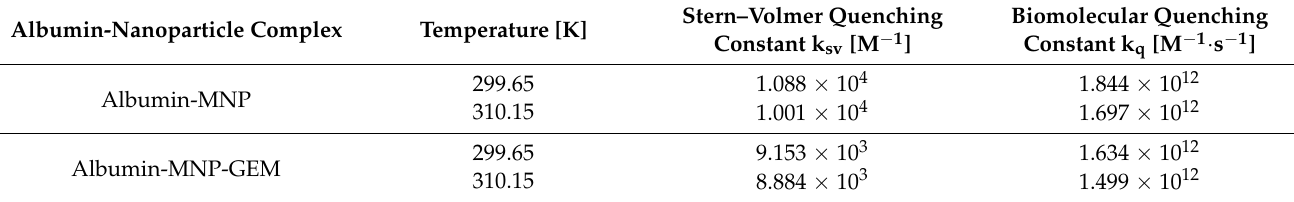
Table 1. The quenching constants of albumin by MNP and MNP-GEM at two different temperatures.